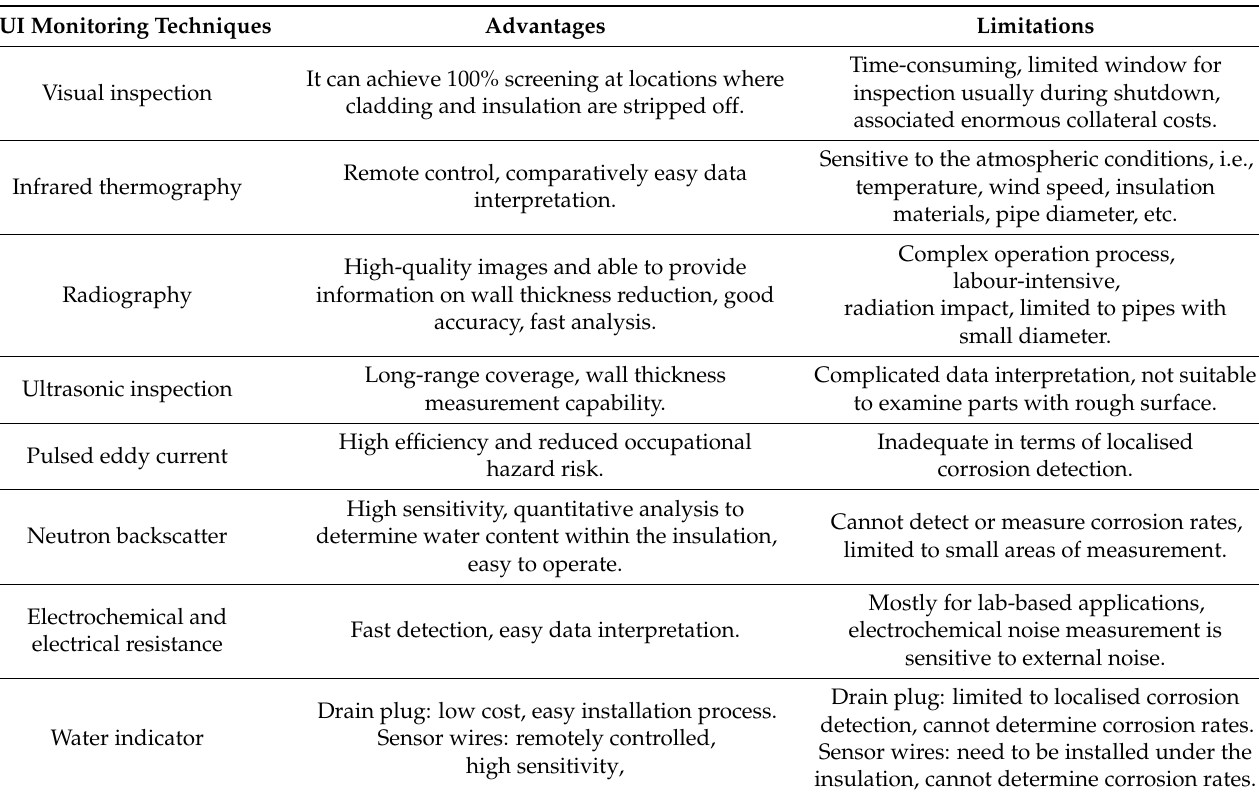
Table 2. A summary of the advantages and limitations of current CUI monitoring